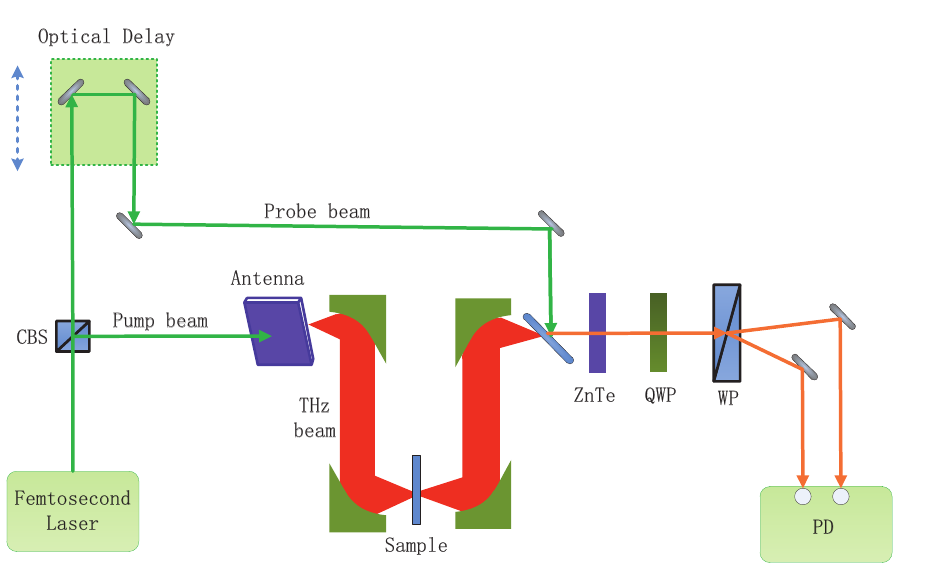
Figure 2. The schematic diagram of THz–TDS system.